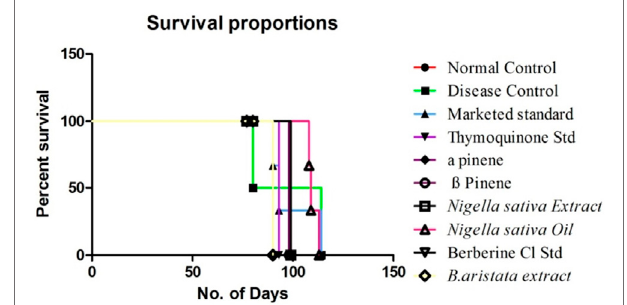
FIGURE 5 | Effect of treatment on the MST using Kaplan Meier ’ s